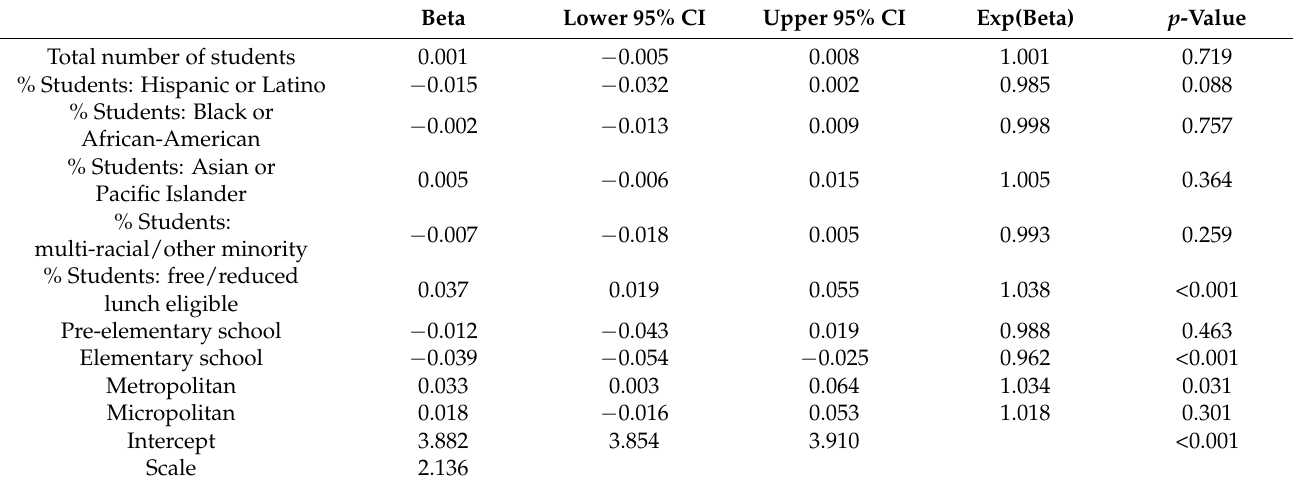
Table 4. Multivariable GEE for predicting road noise exposure in Texas public schools.